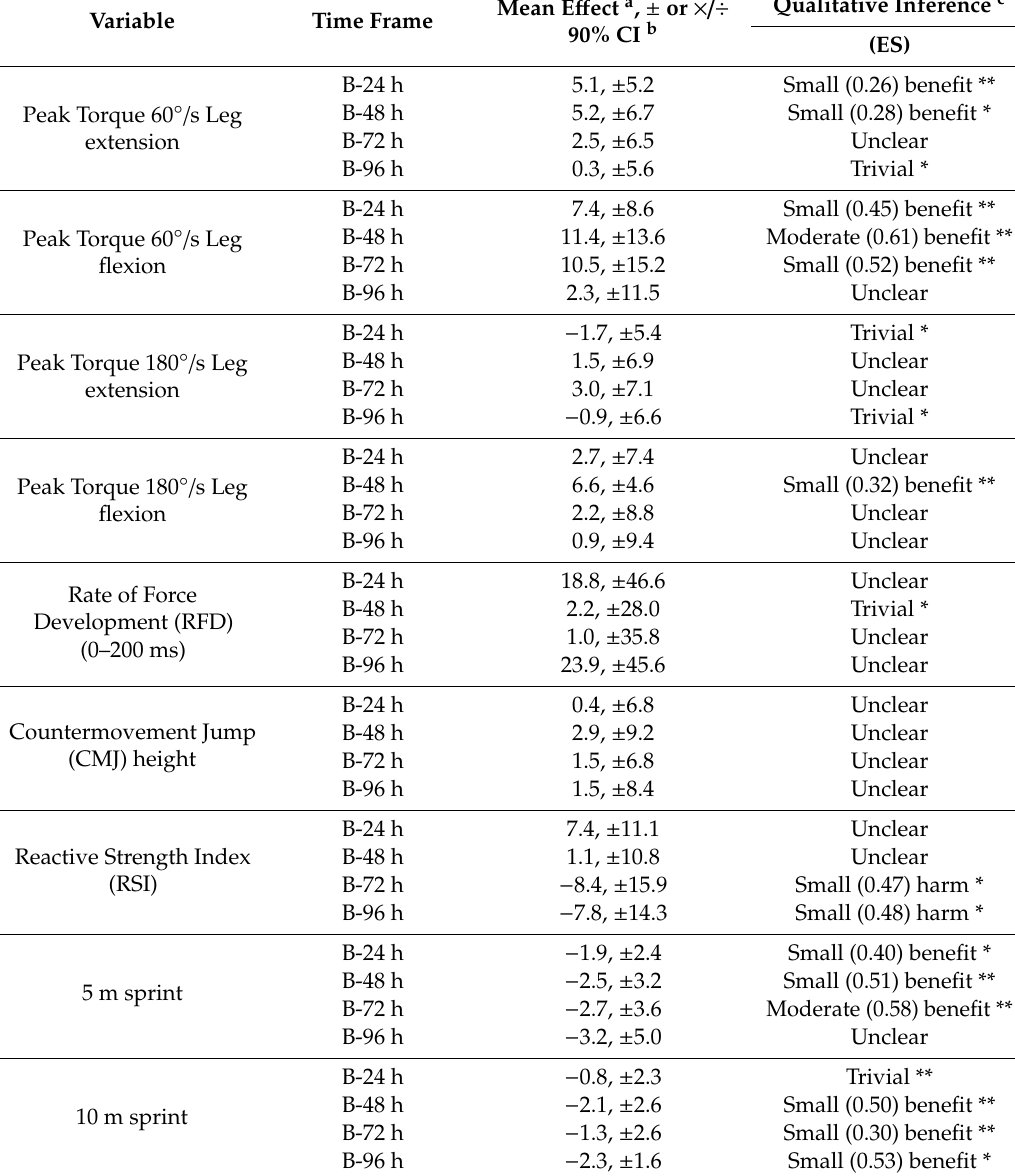
Table 1. E ff ects of MILK vs. CHO on muscle function, soreness, tiredness, symptoms of stress, serum creatine kinase (CK), high sensitivity C-reactive protein (hsCRP), LOOHs and PCs following repeated simulated team-sport